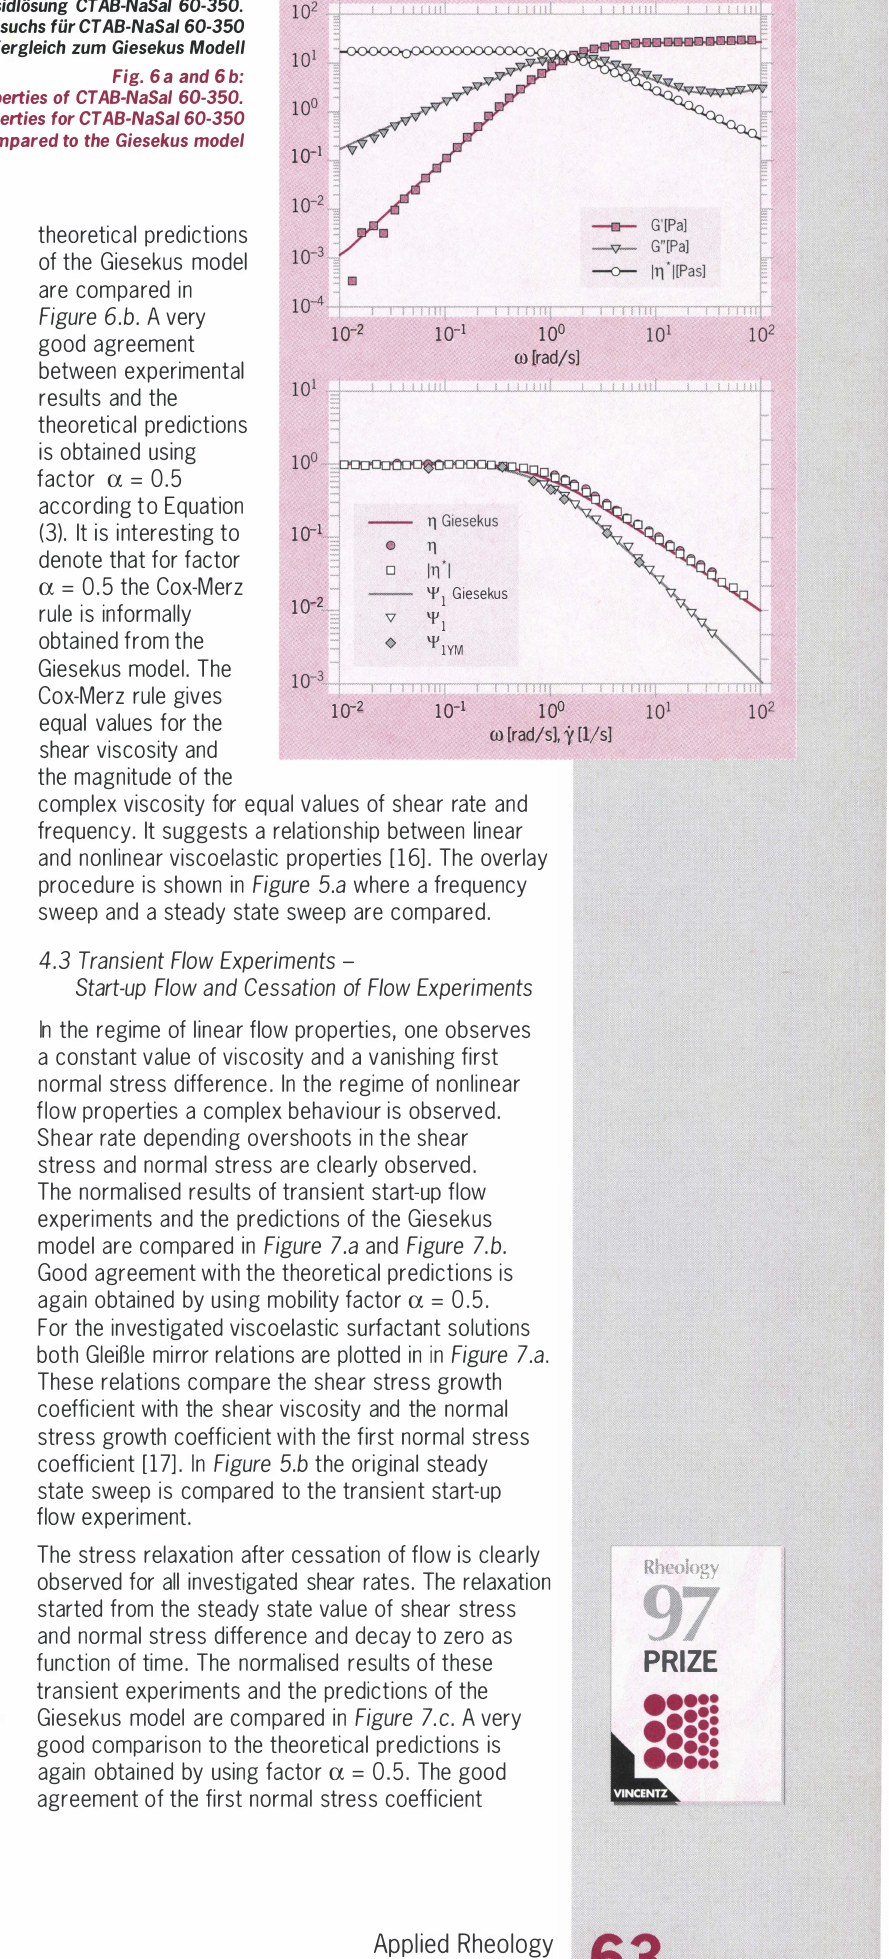
Fig. 6a and 6b: a.) Dynamic shear flow properties of CTAB-NaSal 60-350. b.) Steady state flow properties for CTAB-NaSal 60-350 compared to the Giesekus